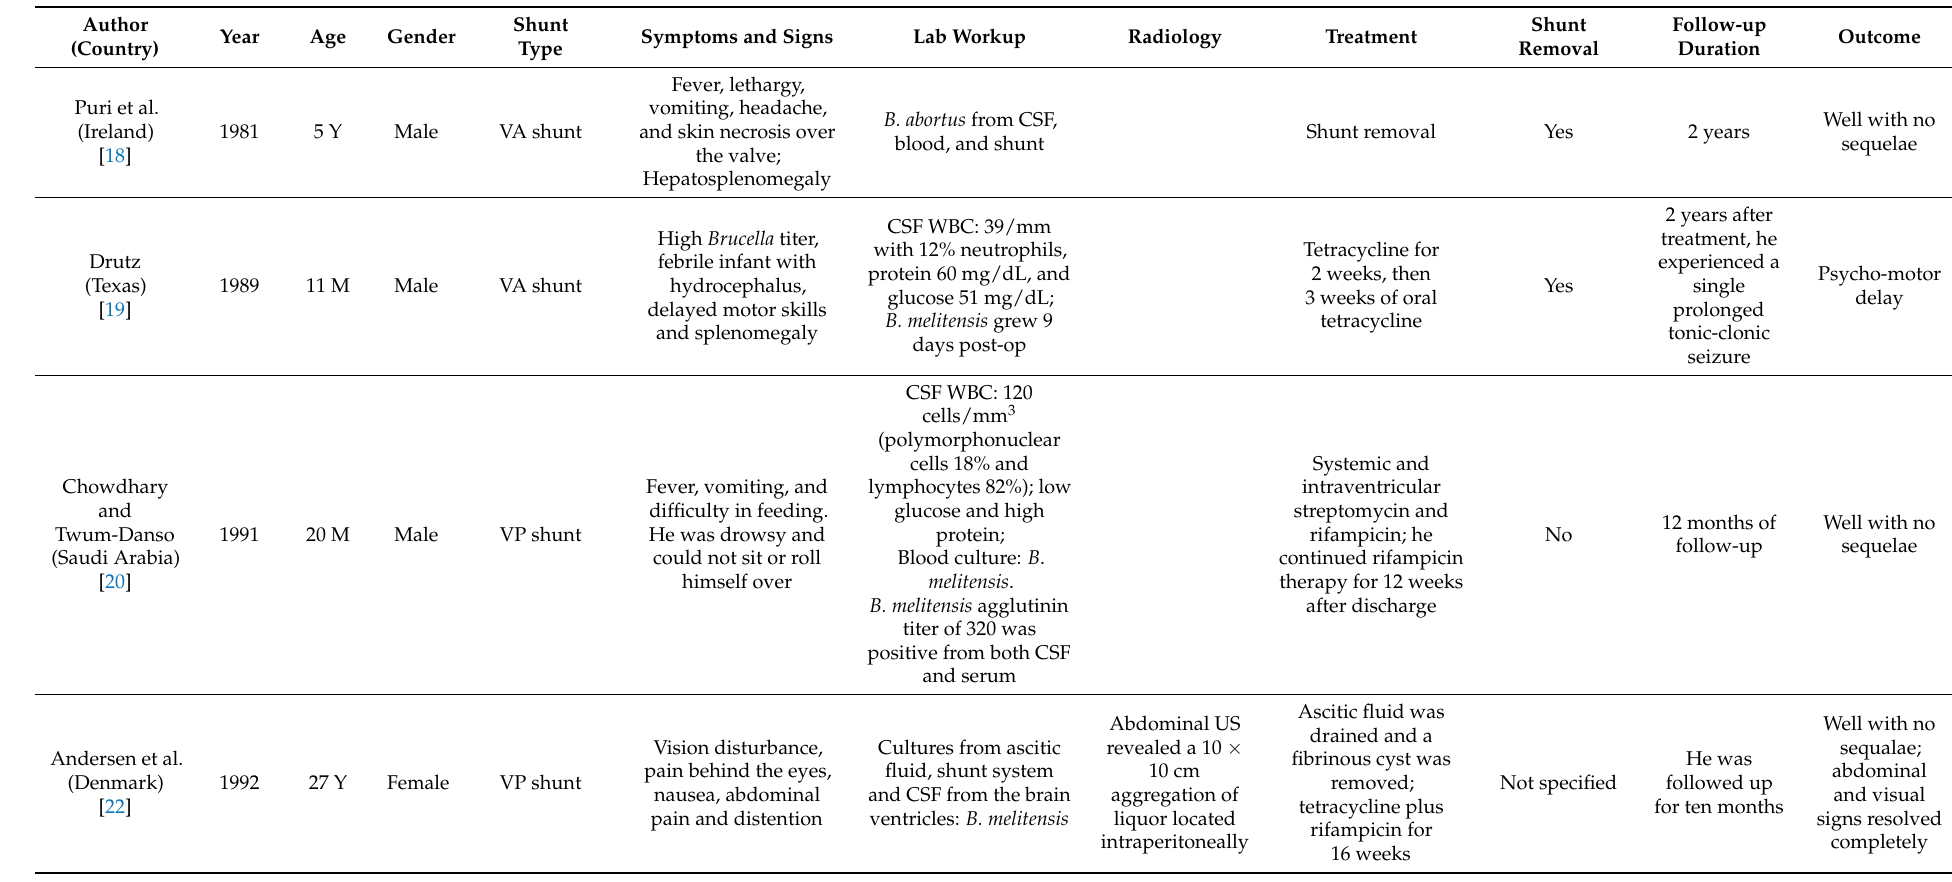
Table 1. A summary of the previously reported cases of Brucella shunt